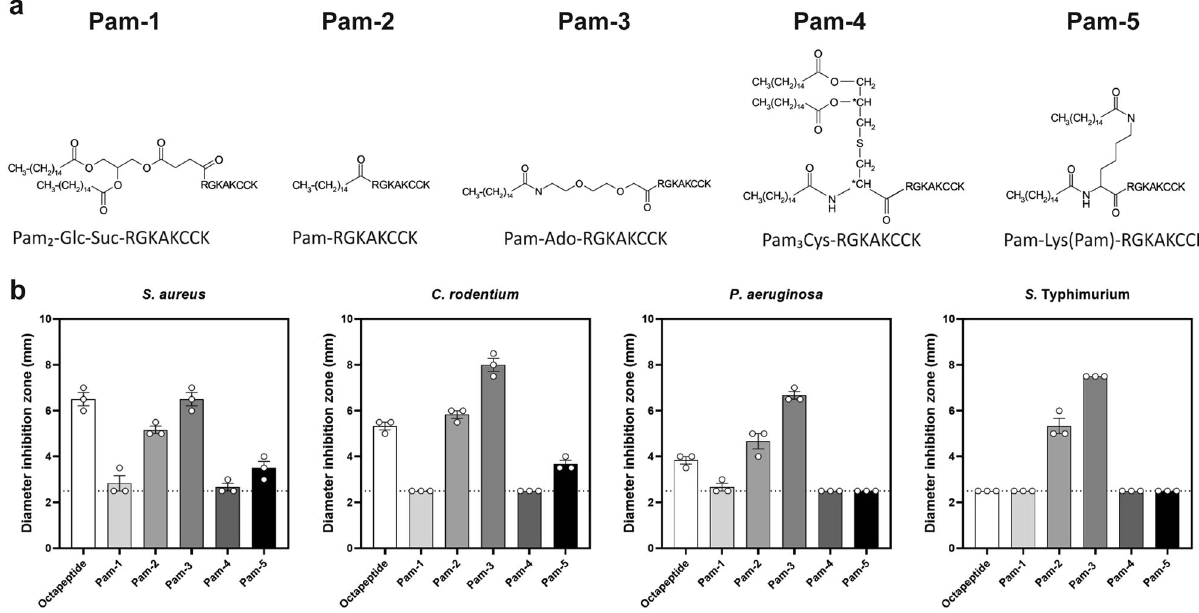
Fig. 1 Screening of differently modi fi ed octapeptides reveals peptides with improved antimicrobial activity. a Octapeptide, the C-terminal eight amino acids of human β -defensin 1, was chemically modi fi ed with palmitic acid and different spacers such as sugars or amino acids or 8-amino-3.6-dioxaoctanoic acid (Ado) to generate lipopeptides. b Antimicrobial activity was measured by radial diffusion assay. The diameter of inhibition zones indicates antimicrobial activity; a diameter of 2.5 mm (dotted line) is the diameter of an empty well. Results are means± SEM of three independent